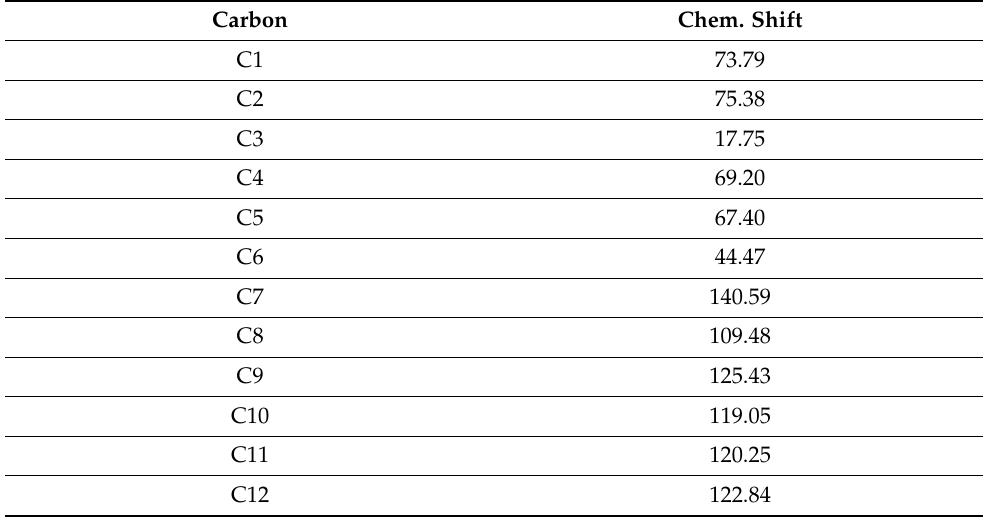
Figure 3. 13 C NMR spectrum of PPO- b -PEPK copolymer sample 2 (Solvent: CDCl 3 (*), TMS. scale, 25 °C). In Table 2, carbon numbers are referred to those in the figure.